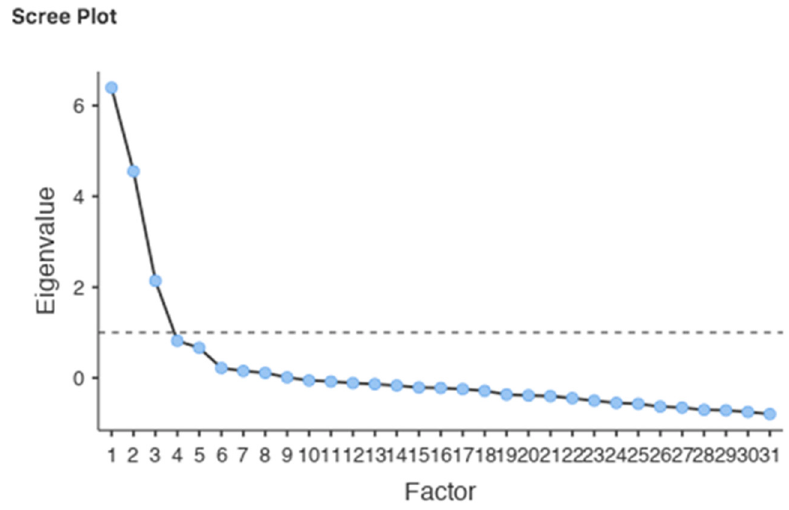
Figure 1. Scree-plot and criteria eigenvalue level.